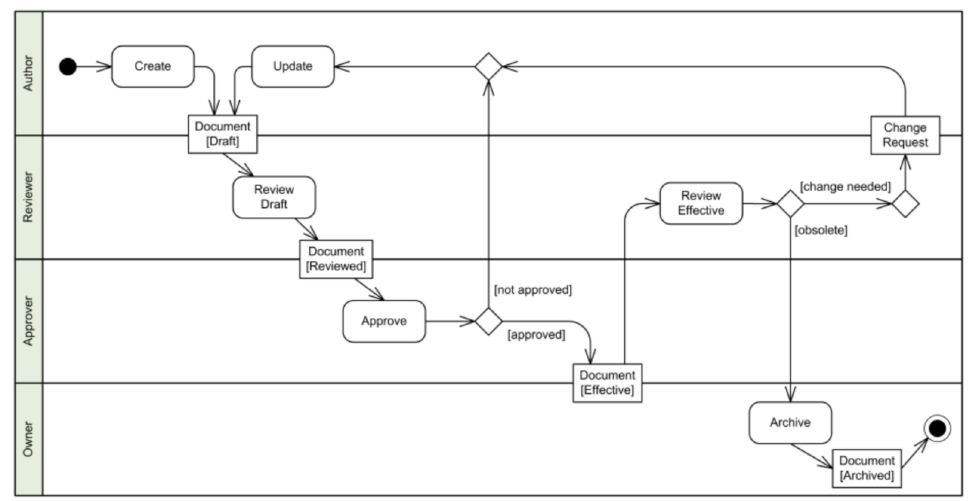
Figure 4. An example of document management process